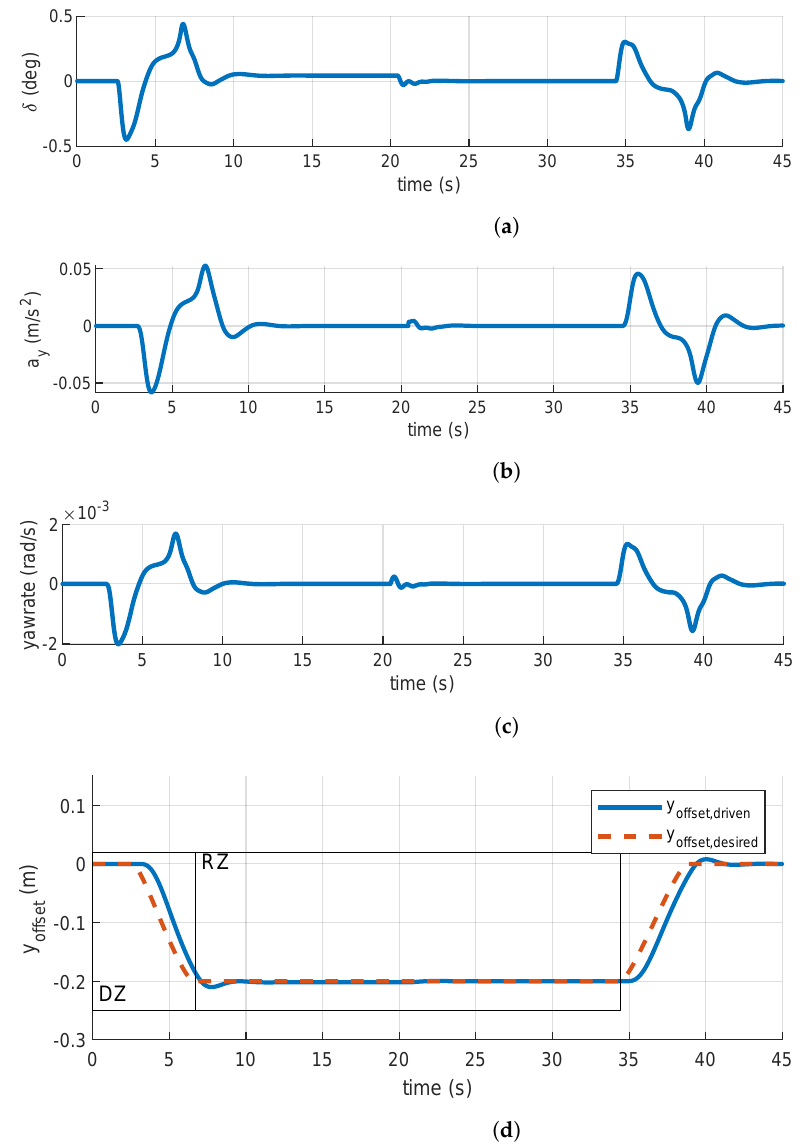
Figure 5. Result of the in-lane off-set recommendation scenario: ( a ) steering wheel angle, ( b ) lateral acceleration, ( c ) yaw rate, and ( d ) lane